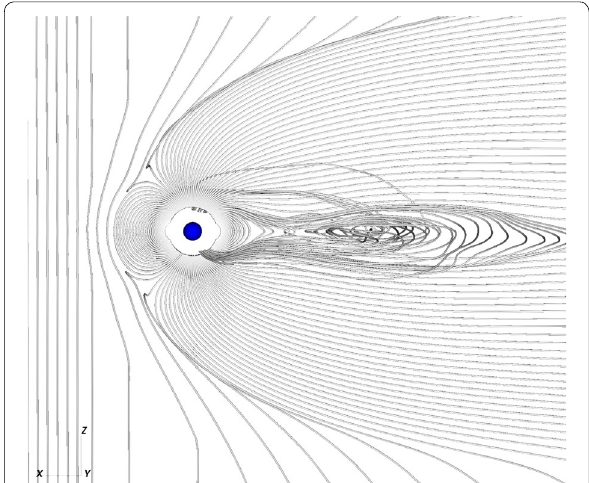
Fig. 2 Magnetic field lines just before the onset of the first substorm expansion onset. The sphere represents the Earth. The Sun is to the